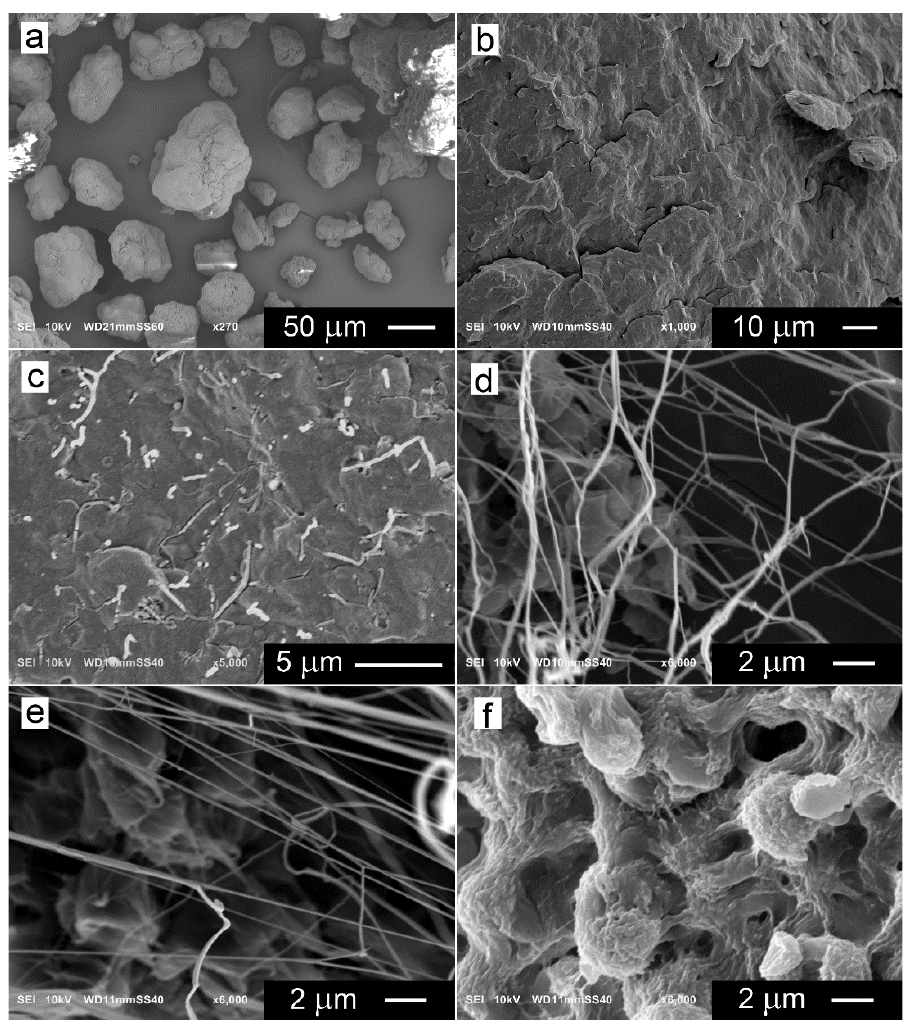
Figure 2. SEM micrographs of PTFE powder ( a ), cryo-fracture surface of neat PP ( b ), and PP/T5 ( c ), PTFE fibrils exposed by dissolution of PP/T5 ( d ) and PP/T1 ( e ), neat PP after treatment with boiling xylene ( f ).